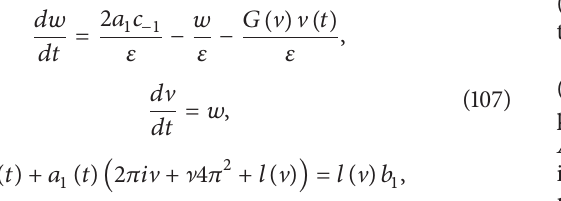
(Stokes friction law) and high Reynolds number (in which the friction is a quadratic law).